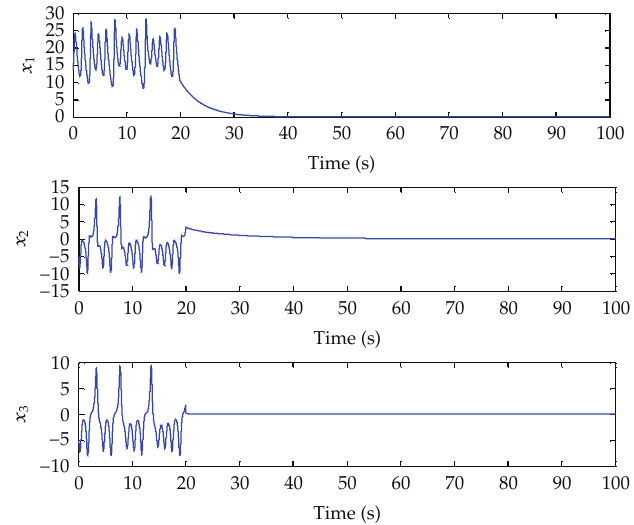
Figure 3: The state responses of the controlled PMSM